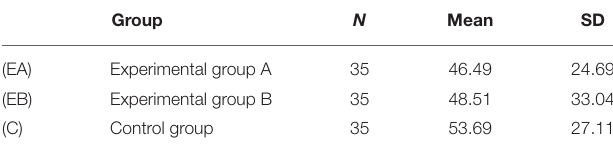
TABLE 3 | Pre-test results of the computational